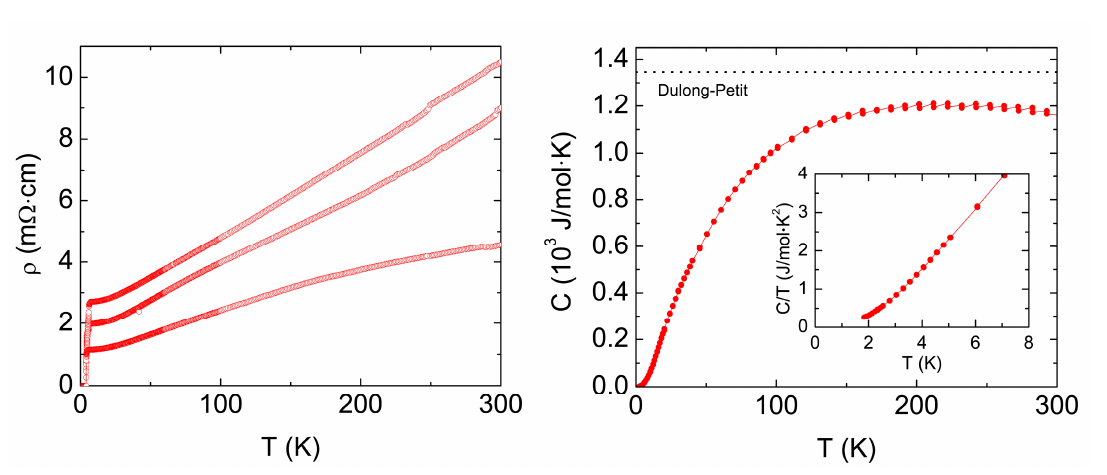
Figure 5. Resistivity and specific heat as a function of temperature of single-crystalline type-I Ba Ga Sn 8 16– x 30+ x